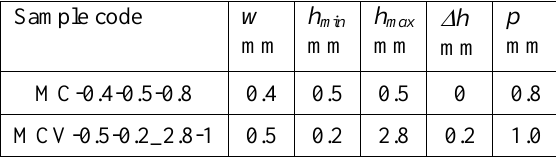
Table 2. MC/MCV surface codes and